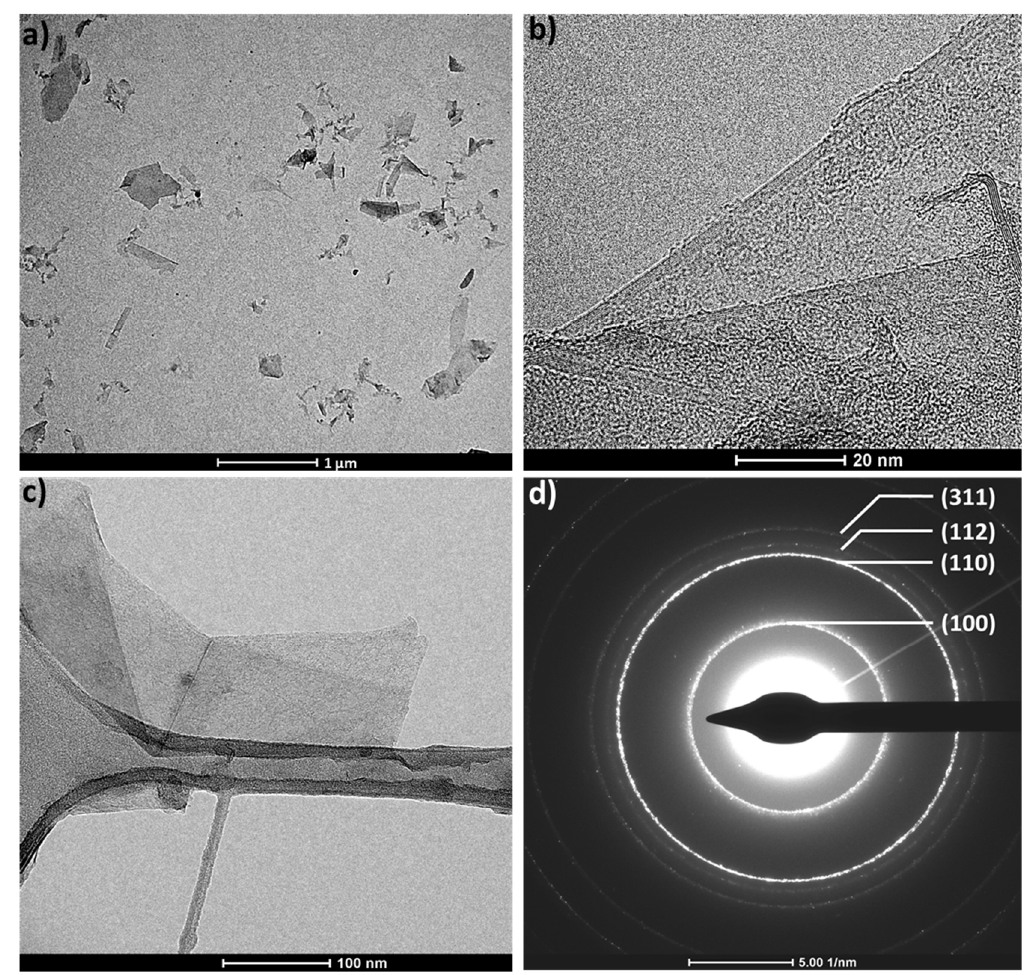
Figure 4. Transmission electron microscopy characterization of the EXG 3000 40 min sample. ( a ) Low magnification TEM image of the sample. ( b ) HR-TEM high magnification detail showing a number of superimposed graphene layers in the samples equal to 5. ( c ) HR-TEM detail on the geometrical shape of the flake edges. ( d ) SAED of the edges with indicated numbers of the identified reflections (see text for speciations).